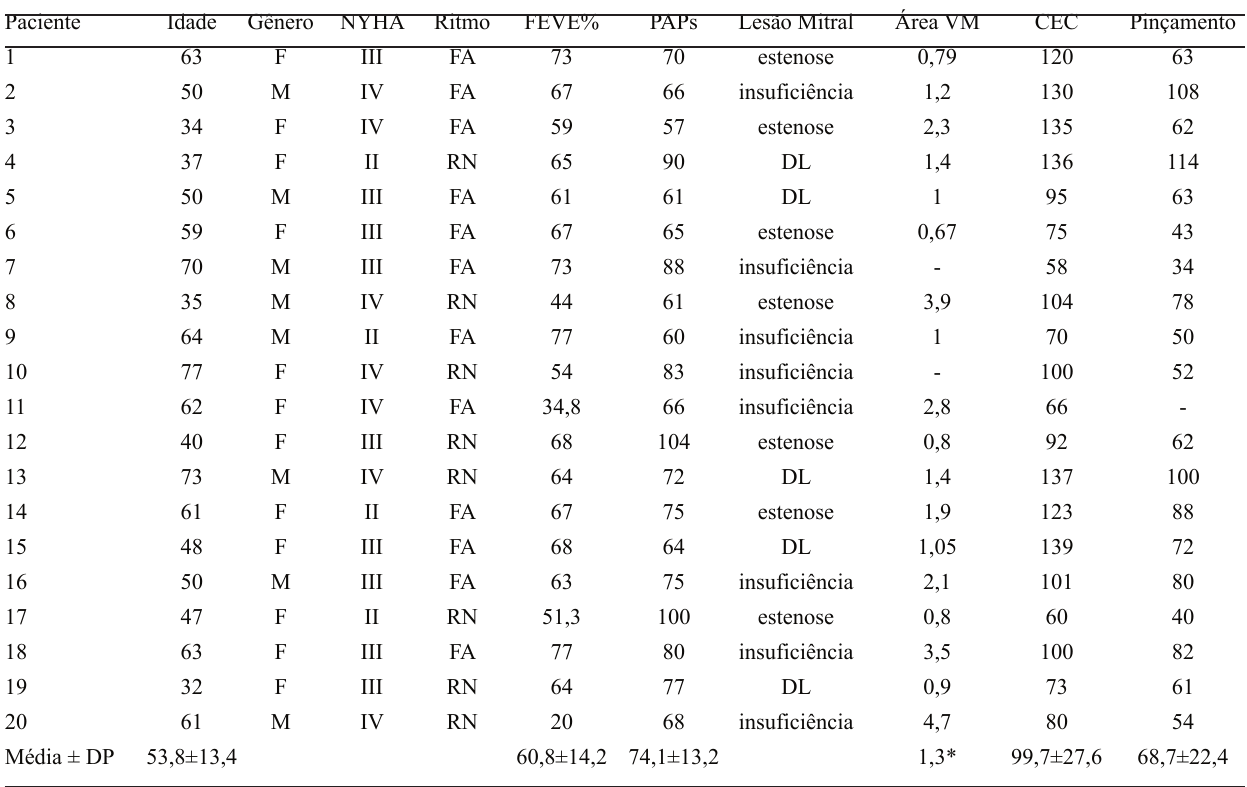
Tabela 1. Dados demográficos e clínicos